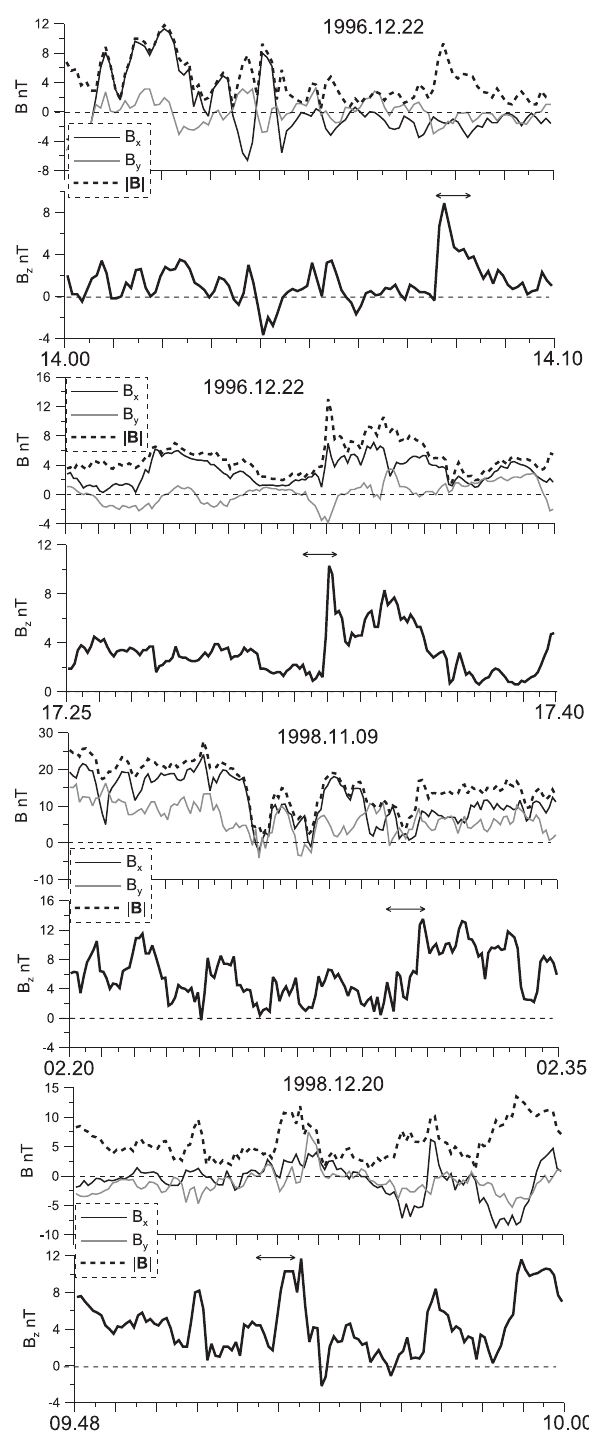
Fig. 3. Four events of DF observations by Interball-tail (x-axis is in UT). The date is given at the top of each